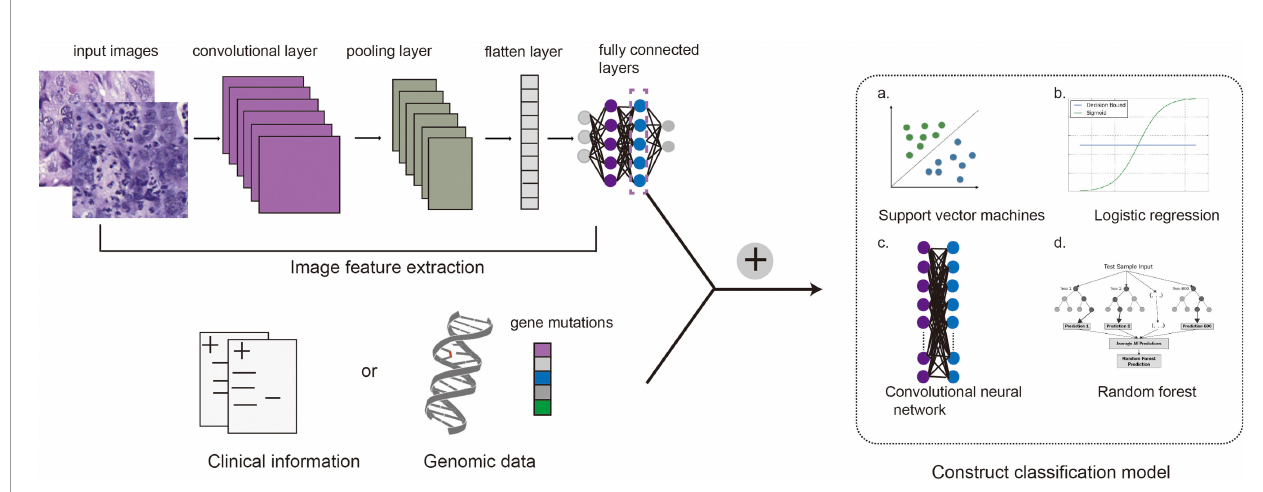
FIGURE 2 | Main process of constructing a compound framework by combining pathological images with genomic data or clinical information. Convolutional neural networks are commonly used to extract image features, and then genomic features or clinical information are integrated into the full connection layer. Support vector machine (a), logistic regression (b), convolutional neural network (c) or random forest (d) can be used to establish the fi nal multimodal fusion